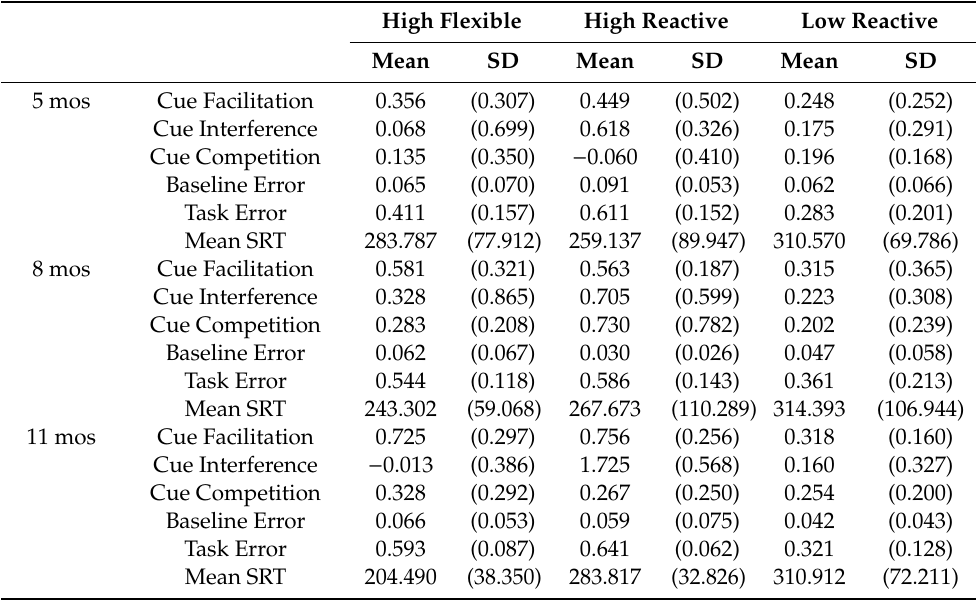
Table 2. Attention score means and standard deviations by phenotype and